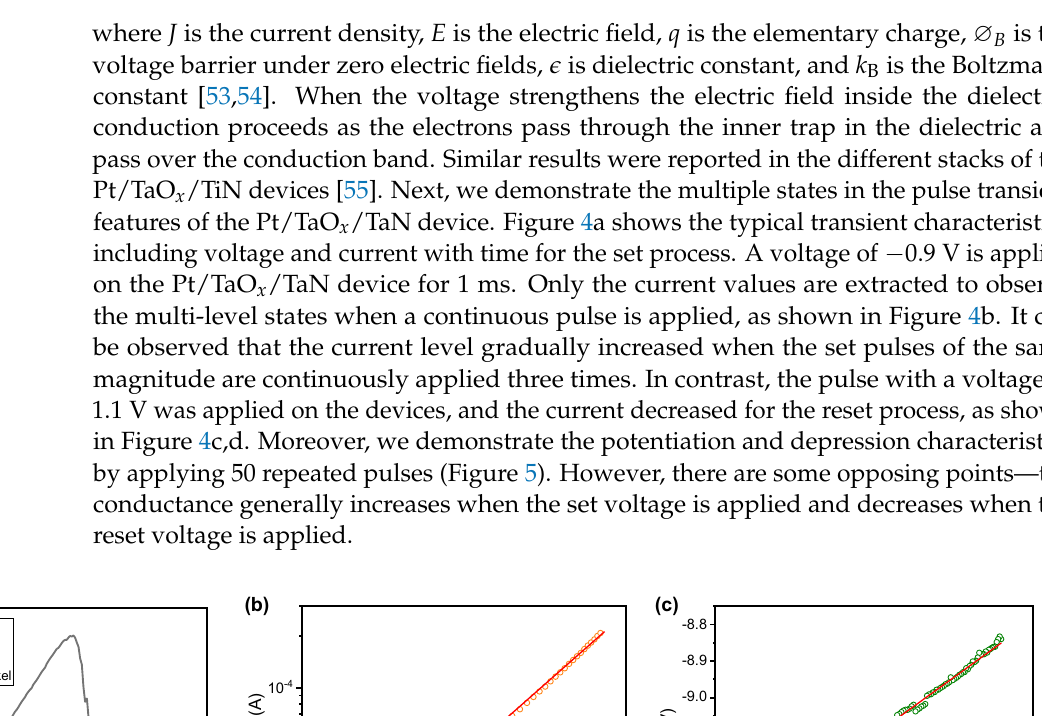
0.0 0.2 0.4 0.6 0.8 1.0 1.2 1.4 1.6